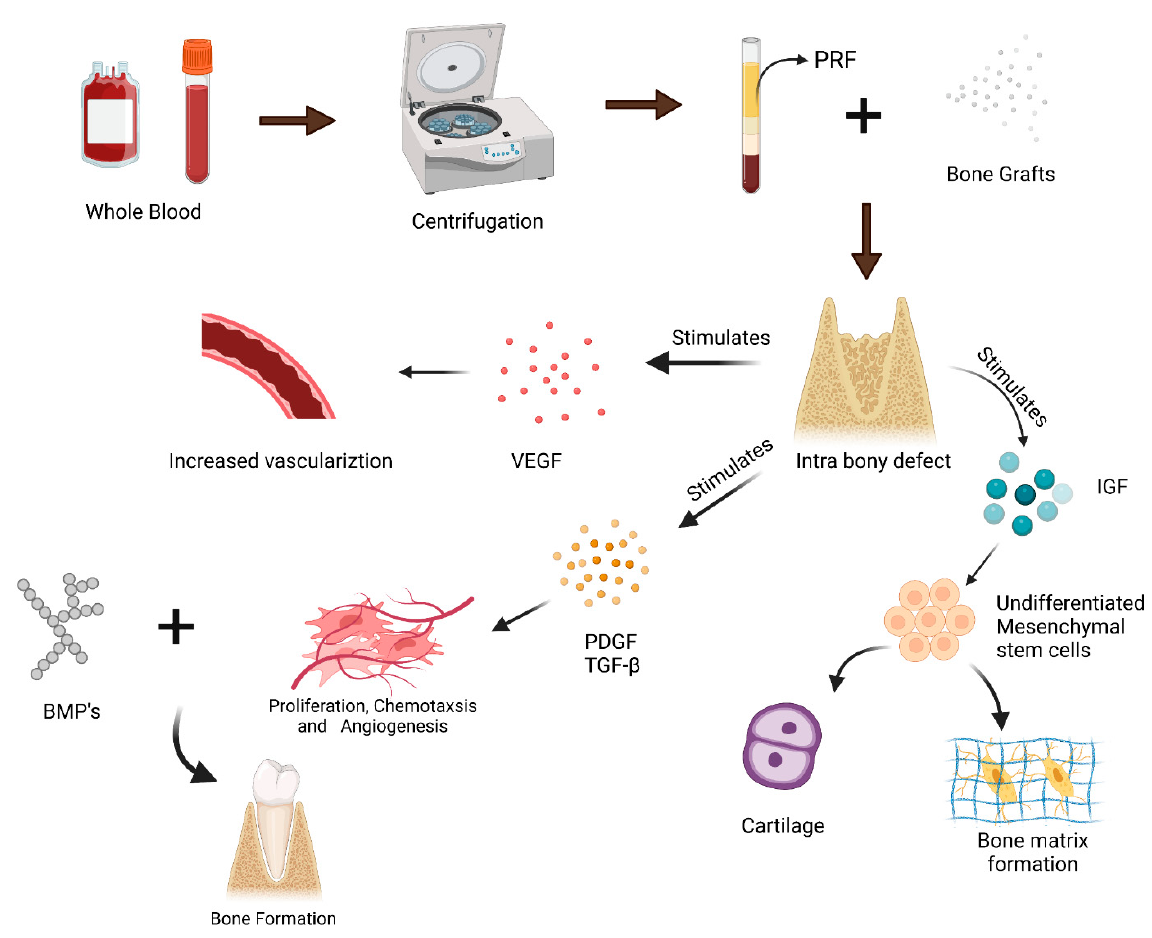
Figure 1. Sequential events that depict the bone regeneration after PRF application .